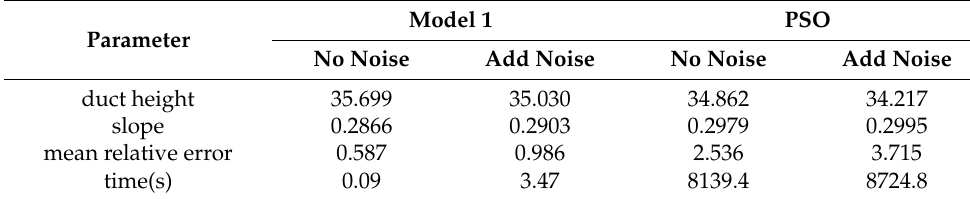
Table 4. Evaporation duct prediction results.